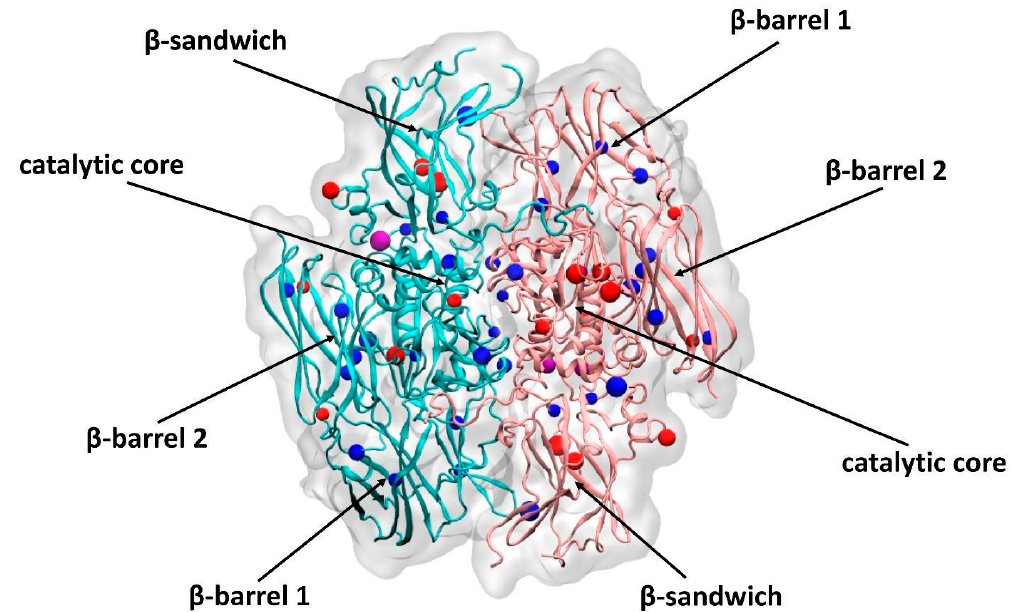
Figure 7. The presentation of the catalytic FXIII-subunit dimer crystal structure (PDB ID: 1F13) with the oxidative modifications detected in the oxidized samples. The left (blue) and right (pink) monomers represent the catalytic subunit structure of FXIII treated with 50 µ M and 150 µ M hypochlorite, respectively. The amino acid residues damaged by hypochlorite in the 50 µ M oxFXIII and 150 µ M oxFXIII samples, respectively, are drawn in blue balls; the residues damaged in the 50 µ M oxFXIII + Ca 2 + and 150 µ M oxFXIII + Ca 2 + samples are violet; the residues damaged in the 50 µ M oxFXIII + Ca 2 + / Thr or 150 µ M oxFXIII + Ca 2 + / Thr samples are red. The size of each ball depends on the molecular mass of the modified residue (the oxidation degree of each hypochlorite-modified residue is shown in Table S2). The image was made using the VMD1.9.3 (University of Illinois at Urbana, IL, USA; Champaign, IL, USA) program.